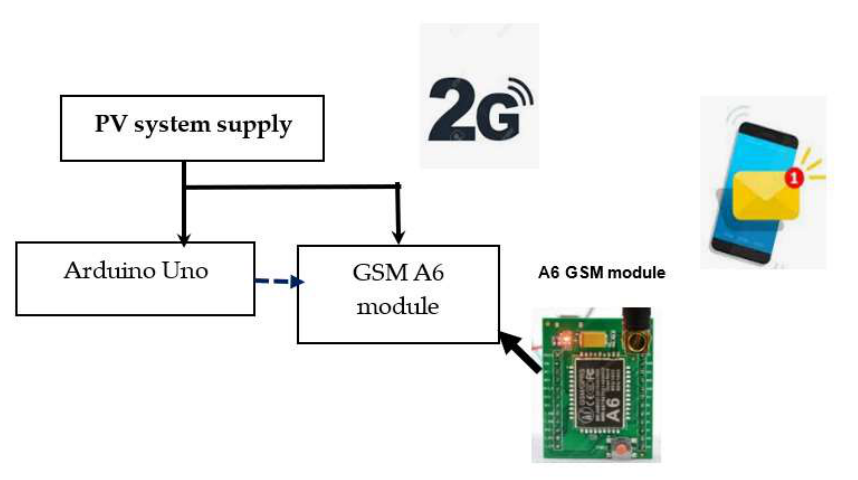
Figure 5. Mobile application structure for SMS notification.